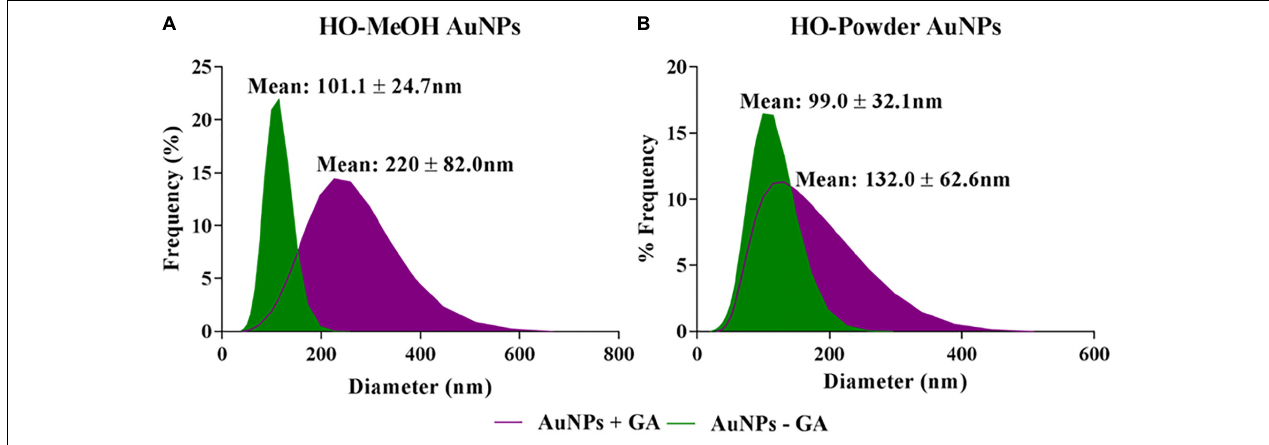
FIGURE 4 | Hydrodynamic diameter of stabilized and un-stabilized (A) Helichrysum odoratisimum methanol extract and (B) H. odoratissimum leaf powder gold